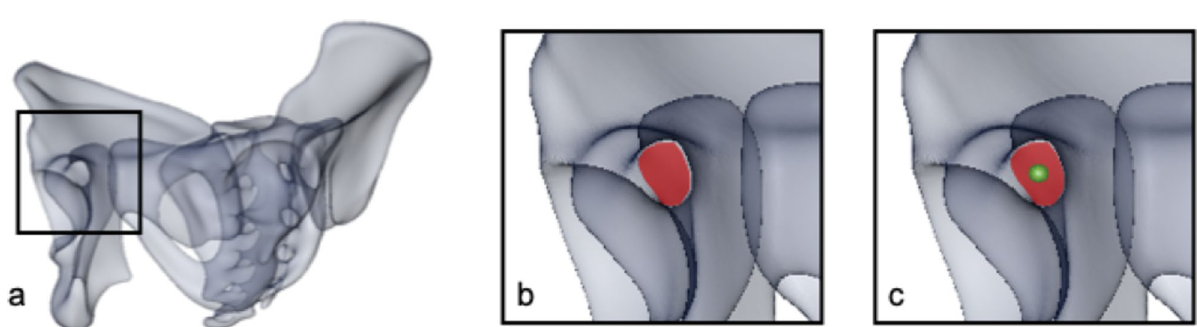
Figure 2. (a) Orientation of the 3D model in so-called gun barrel view 25 , (b) screw corridor (marked in red), (c) marked screw entry point in the center of the corridor (green dot). This figure was generated using the software Amira (Version 6.0.0, FEI, Hillsboro, OR, USA; www. fei.